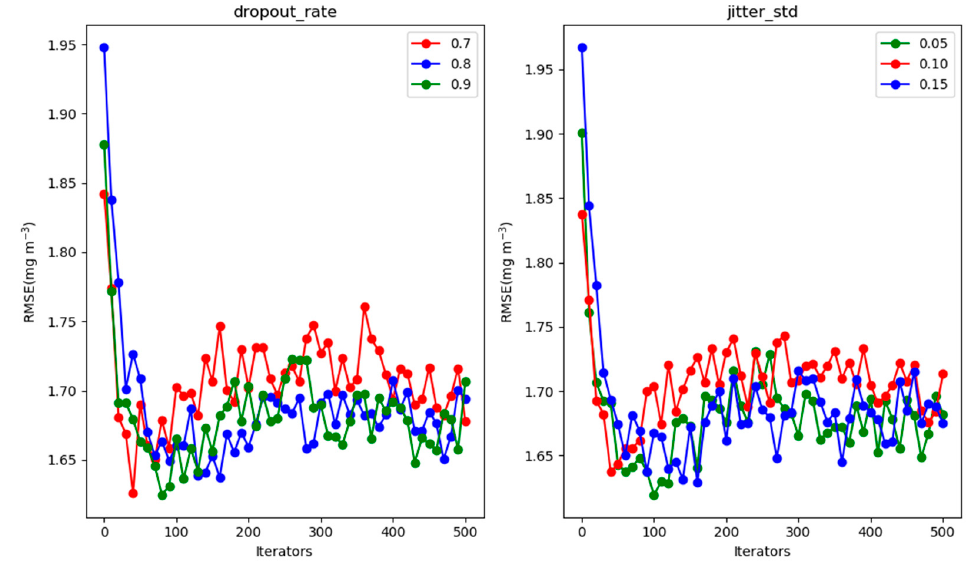
Figure 7. Hyperparameter − fi nding experiments for DINCAE. The optimal dropout rate was chosen from (0.7, 0.8, 0.9) and the optimal ji tt er std was chosen from (0.05, 0.10, 0.15).